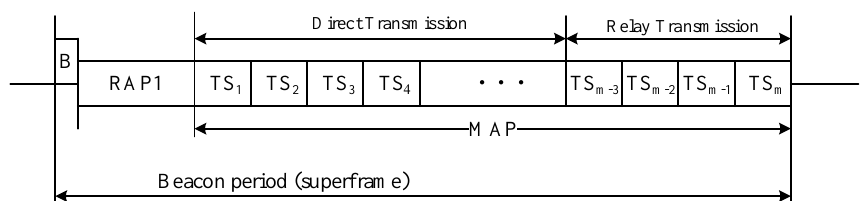
Figure 2. Superframe structure for